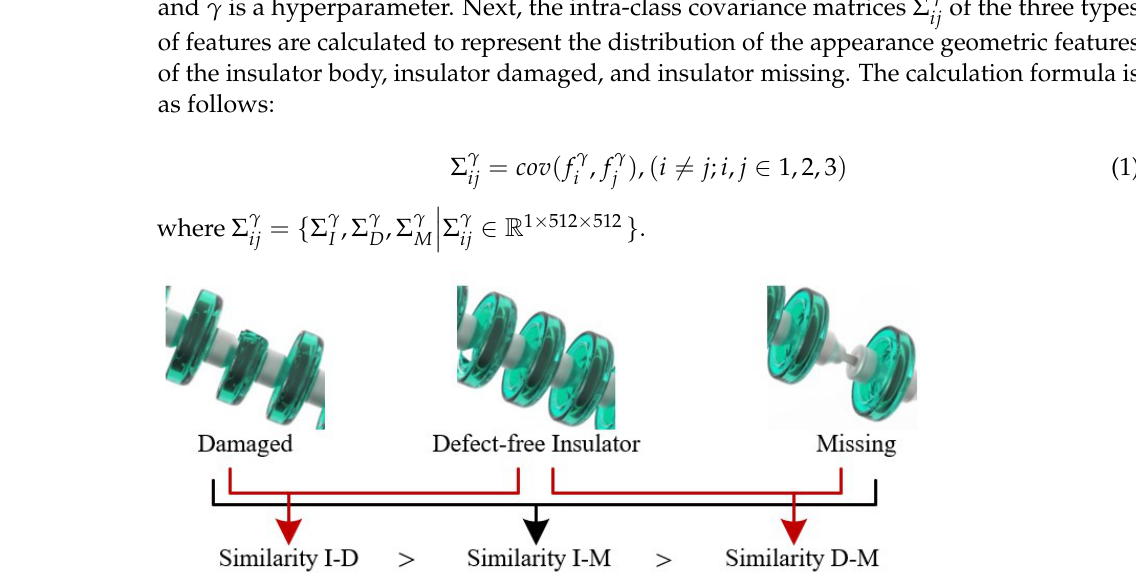
Figure 5. Similarity ranking of insulators with damaged and missing defects compared with the defect-free